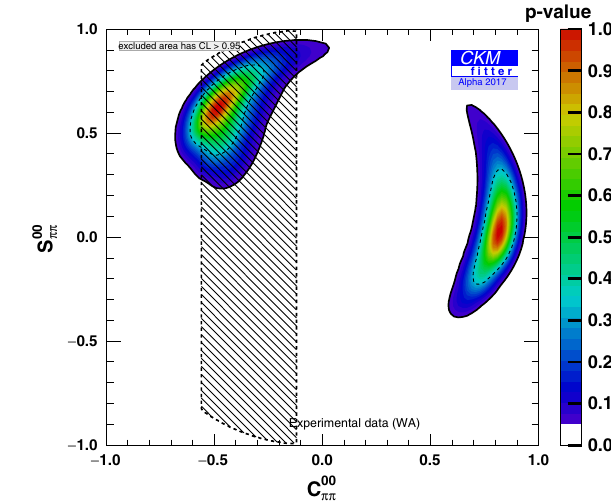
try C 00 is measured in the B 0 → π 0 π 0 decay and we represent the direct constraint in the ( C 00 , S 00 ) plane taking the theoretical inequal- ity C 2 + S 2 < 1 into account